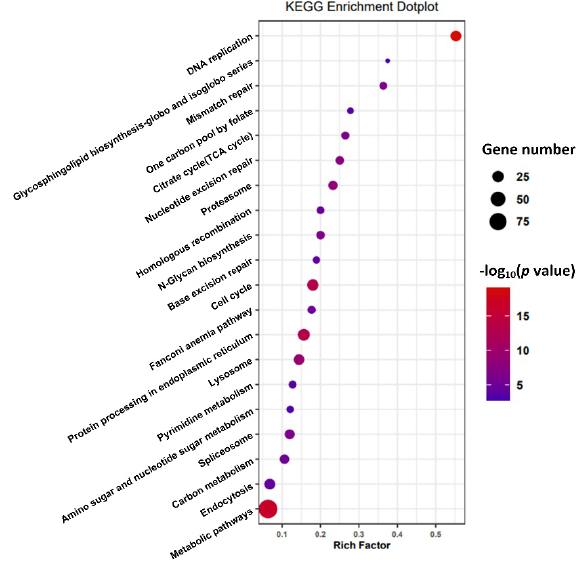
Figure 3. Bubble map of enriched KEGG pathways of DEGs between 36 and 28 ◦ C, under normoxia. On the x-axis, the Rich factor indicates the ratio of numbers of mapped DEGs to mapped total gene numbers in the pathway. The larger the Rich factor, the more significant is the enrichment. The y-axis displays the first 20 significantly enriched signal pathways. The − log 10 ( p -value) indicates statistical significance, coloration from purple to red indicates the degree of significance from low to high.